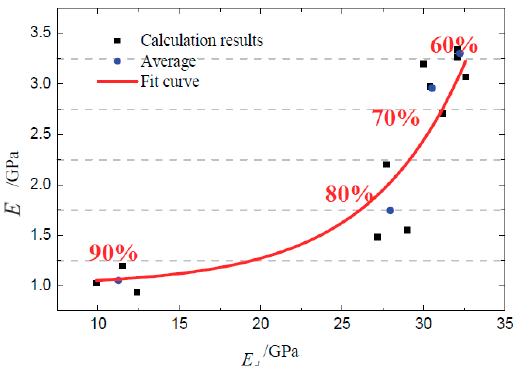
Figure 13. The relationship between the dynamic elastic modulus and elastic modulus in the intact state.